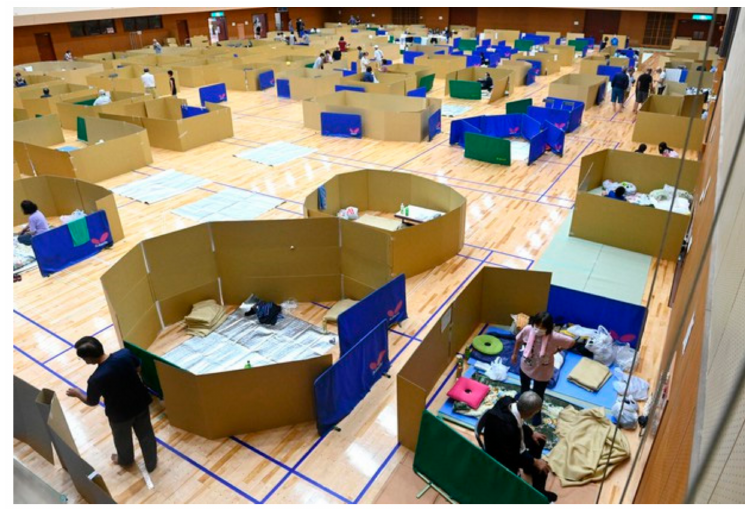
Figure 2. Public gym in Yatsushiro, Kumamoto Prefecture (Mainichi,